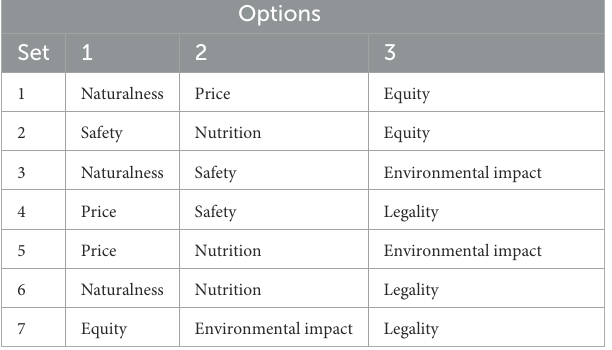
TABLE 2 Balanced incomplete block design.